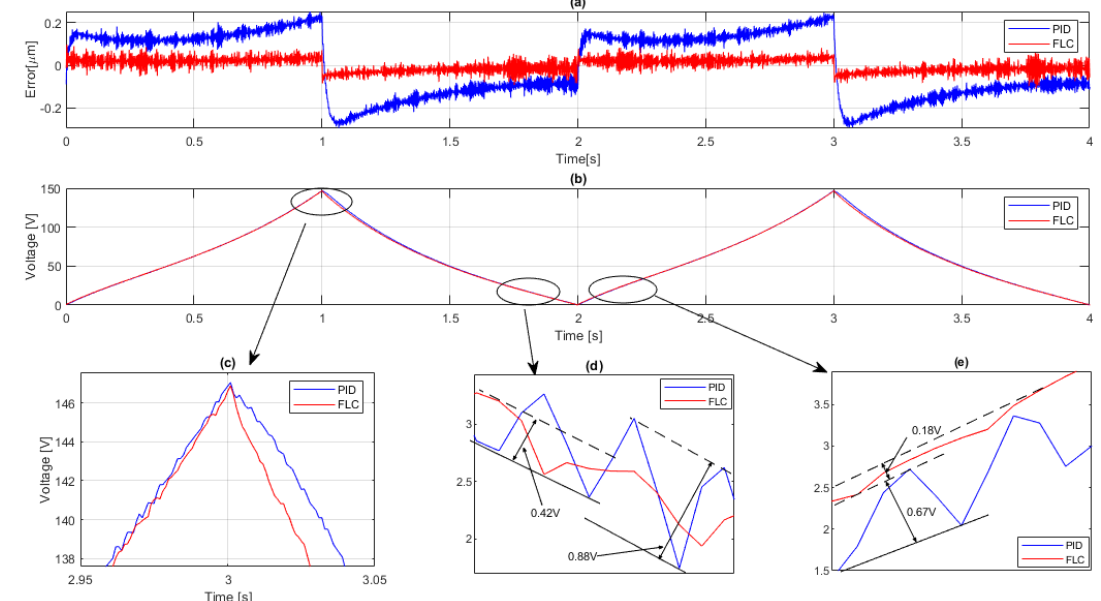
Figure 7. Comparison of error and control signal between PID and FLC. ( a ): Error; ( b ): Control signal; ( c ) Control signal at the top peak; ( d ): Control signal near the lower peak; and, ( e ): Control signal after the lower